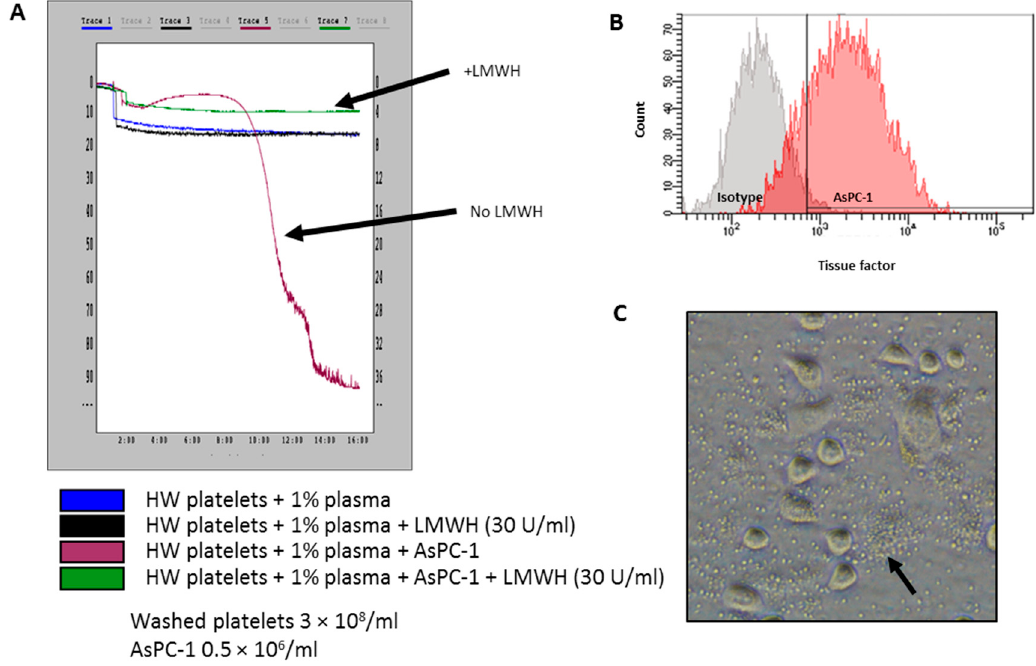
Figure A2. AsPC-1 expresses tissue factor, and causes platelet aggregation ( A ) Light transmission aggregometry showed that AsPC-1-induced aggregation of human washed (HW) platelets, which was tissue factor-dependent, as addition of low-molecular-weight heparin (LMWH) prevented platelet aggregation. The downward-slope represents light transmission approaching 100%, which is indicative of platelet aggregation; ( B ) Flow cytometry analysis of AsPC-1 cells stained with anti-tissue factor show AsPC-1 expressing tissue factor above isotype control; ( C ) Phase-contrast images show platelets aggregating (black arrow) around AsPC-1 cells.